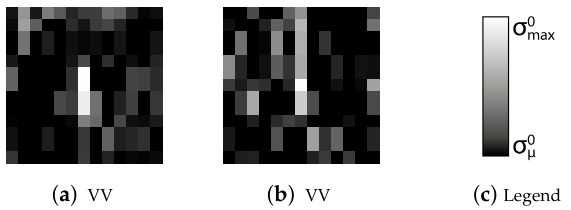
Figure 7. The vessel’s radar footprint in S1 Interferometric Wide (IW) swath mode (©ESA,